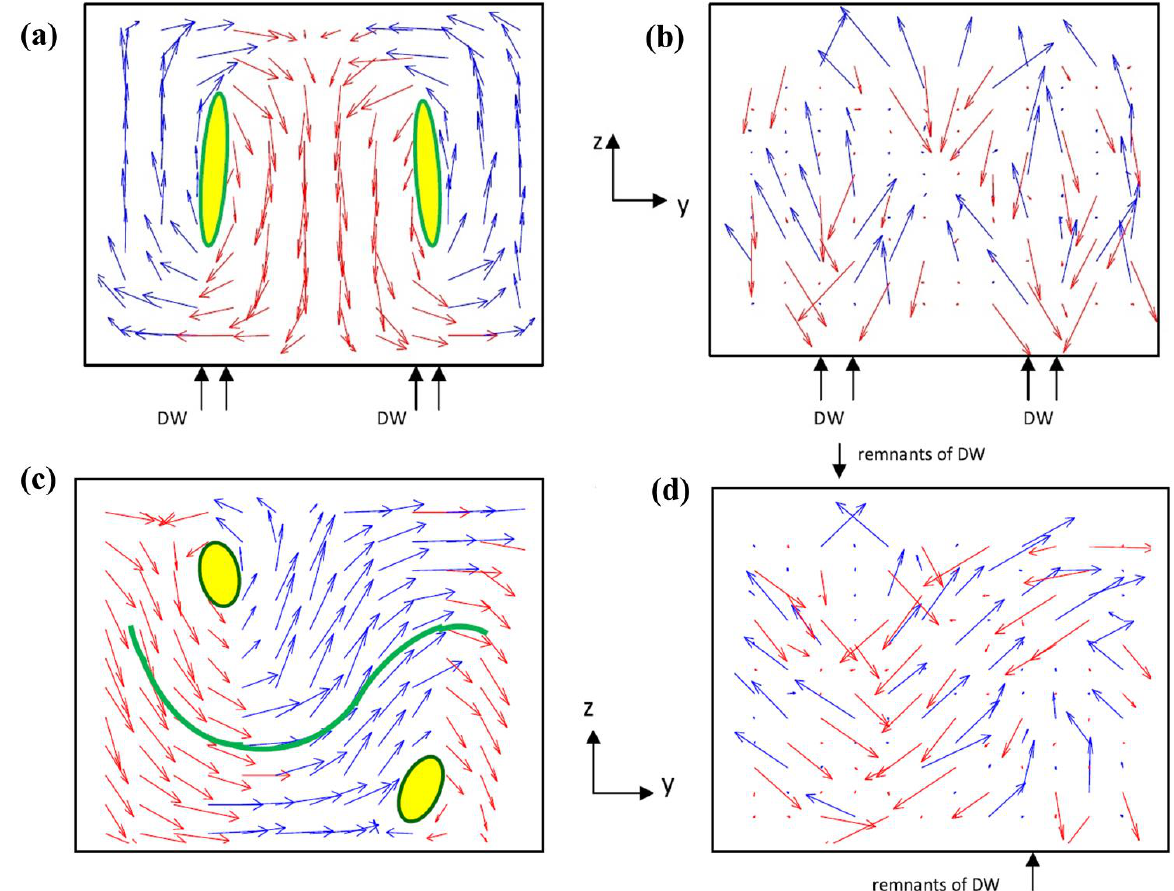
Figure 12. A 10K pattern of the ( a ) electric dipoles and ( b ) AFD vectors in a ( y , z ) plane for the c d [ R ( c )] state; and ( c ) electric dipoles and ( d ) AFD vectors in a ( y , z ) plane for the aac d [ R ( ac )] state of a 4.8nm-thick PbZr 0.52 Ti 0.48 O 3 film under a compressive strain of −2%, as mimicked by a 12 × 12 × 12 supercell. (Reprinted with permission from [313]; Copyright 2011 by the American Physical